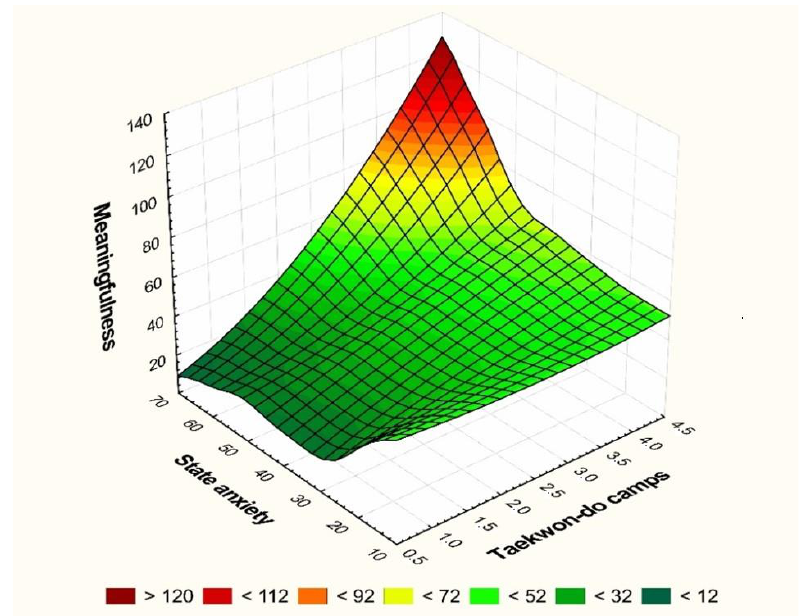
Figure 1. Dependencies between the level of the state of anxiety and the level of meaningfulness and frequency of taekwon-do camps.